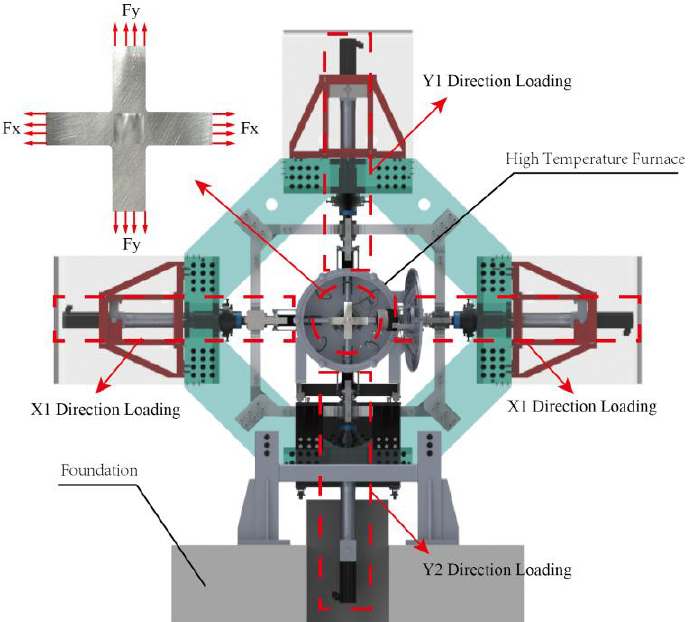
Figure 2. Rack of the biaxial material mechanical properties test apparatus.